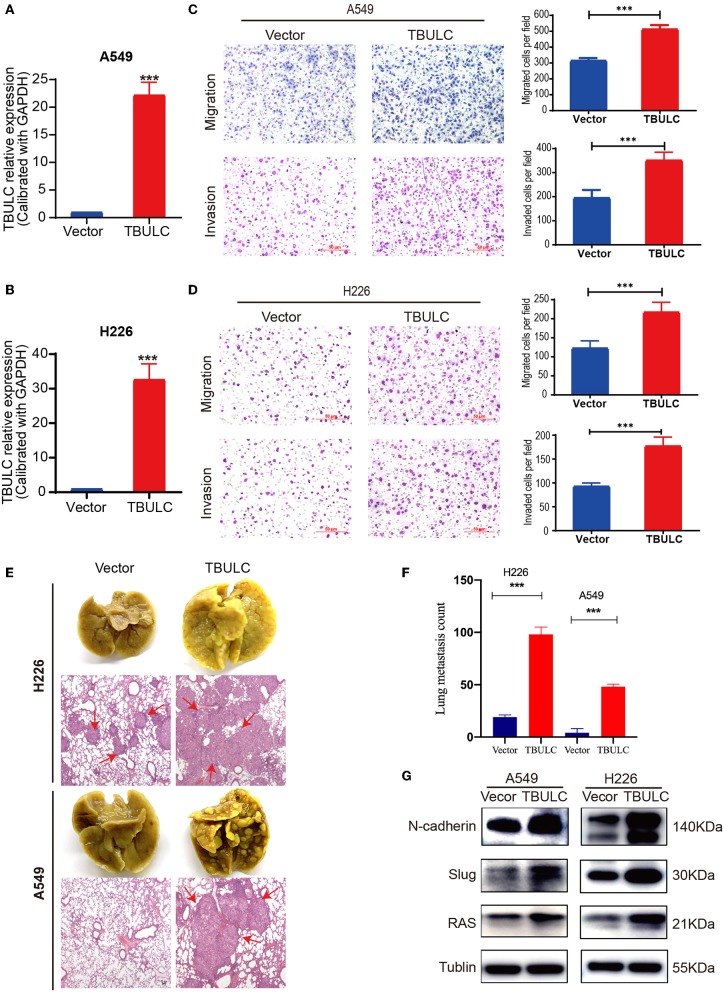
TBULC overexpression promoted cell migration and invasion in vitro and in vivo. (A,B) The expression level of TBULC in stable TBULC overexpression or mock vehicle control-transfected (A) A549 and (B) H226 cell clones. (C,D) The migration and invasion ability of TBULC-overexpressing (C) A549 and (D) H226 cell clones, as well as that of mock vehicle control-transfected cells, as detected by the Transwell assay. The numbers of migrating and invading cells were compared between the groups. (E) Representative images of lung tissues isolated from mice injected with 1 × 106 A549 and H226 cell clones via the tail vein and hematoxylin and eosin-stained images (40×) of such tissues. Red arrows indicate the tumor nodules in the lungs. (F) The number of metastatic nodules in the lungs. (G) Relative expression levels of N-Cadherin, Slug, and Ras by Western blot in TBULC-overexpressing A549 and H226 cells. Tubulin was used as a loading control. The data are shown as the mean ± SD, ***p < 0.001.